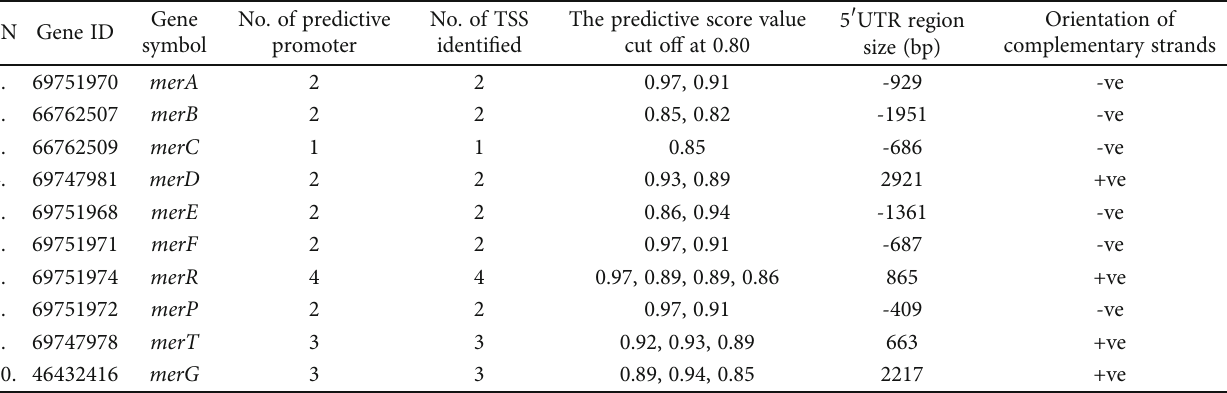
Table 2: TSS number, its promoter predictive score values, and distance from 5 ′ UTR region of the corresponding gene.